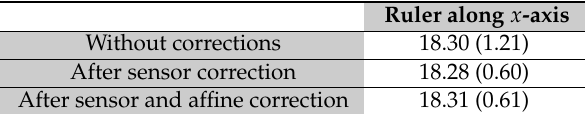
Table 3. Means and standard deviations of pixel resolutions (in pixels · mm − 1 ) measured between each marking or a ruler for a single-channel image resulting from an average of 19 spectral channels without corrections—after sensor correction and after sensor and affine corrections. It can be seen that the pixel resolutions are similar, on average, before and after applying the sensor correction, but the standard deviation is reduced by 2 along the x -axis which means that the sensor correction correctly decreases the cross-track distortion. Note that the affine correction does not impact the pixel resolution along the x